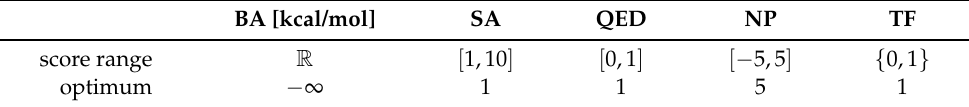
Table 1. The range and optimal score of the binding affinity (BA), synthetic accessibility (SA), quantitative estimate of drug-likeness (QED), and natural product-likeness (NP) metrics. The toxicity filter (TF) is either 0 or